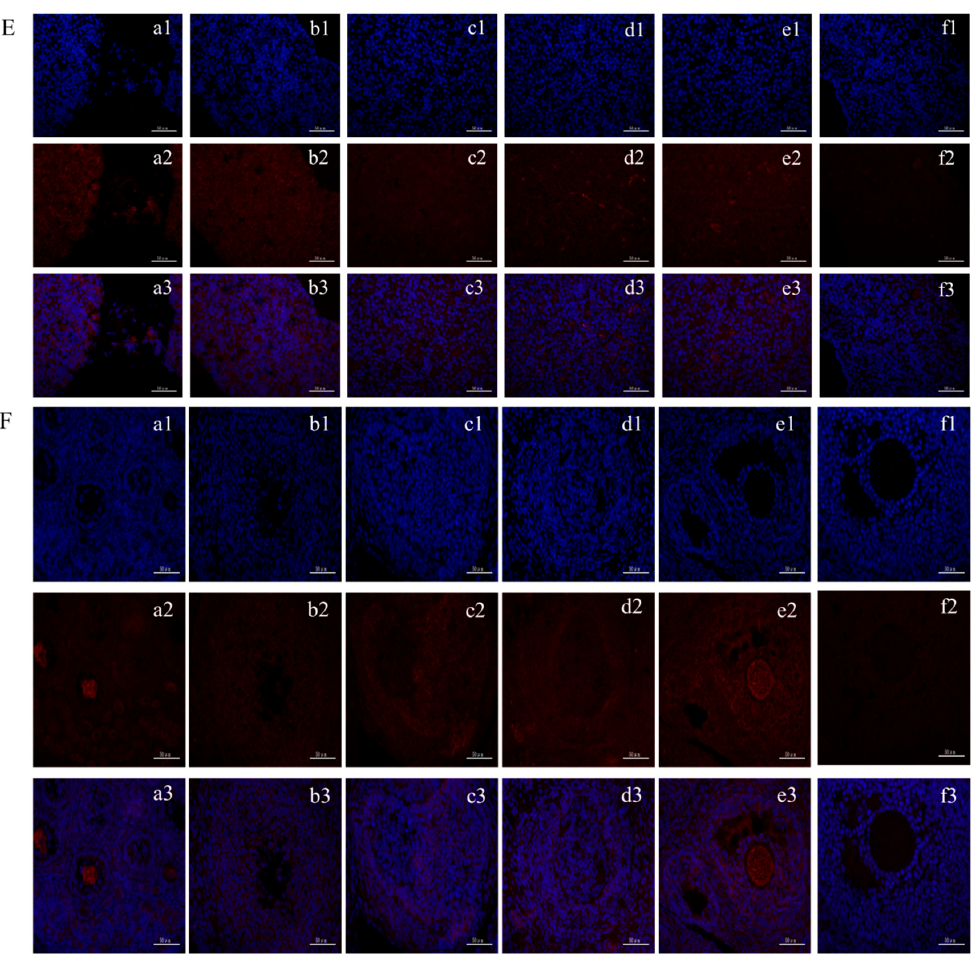
Figure 1. Level of Abat mRNA and distribution of GABA-T protein in hypothalamus, pituitary and ovary of female rats from infancy to adult. ( A ) Relative Abat mRNA expression levels in the hypothalamus from infancy to adult. ( B ) Relative Abat mRNA expression levels in the pituitary from infancy to adult. ( C ) Relative Abat mRNA expression levels in the ovary from infancy to adult. ** indicates a very significant difference ( P < 0.01, n=6); * indicates a significant difference ( P < 0.05, n=6). ( D ) Distribution of GABA-T in hypothalamus. Arcuate nucleus: ARC; Paraventricular